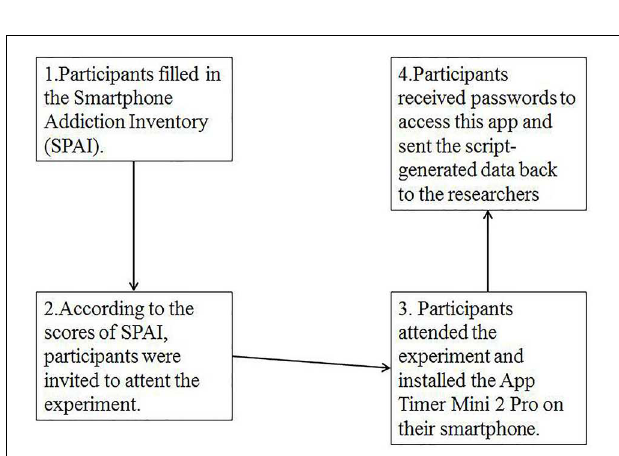
FIGURE 1 | The score of four factors (compulsive behavior, functional impairment, withdrawal and tolerance) in SPAI between groups. Error bars represent standard deviation (SD). ∗ Significant difference refers to a p < 0.05.